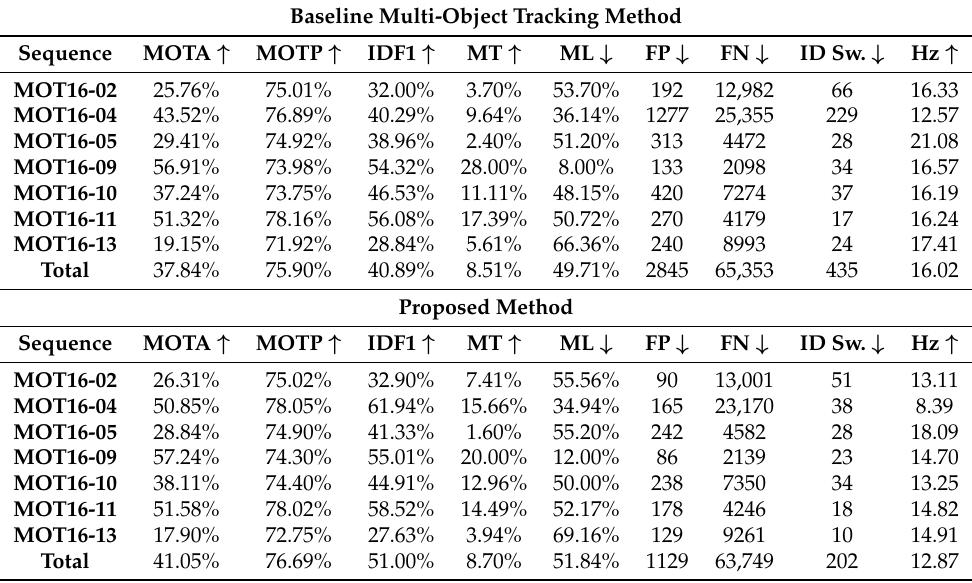
Table 2. Comparison with the baseline confidence-based multi-object tracking method on 2016 MOT benchmark train dataset.